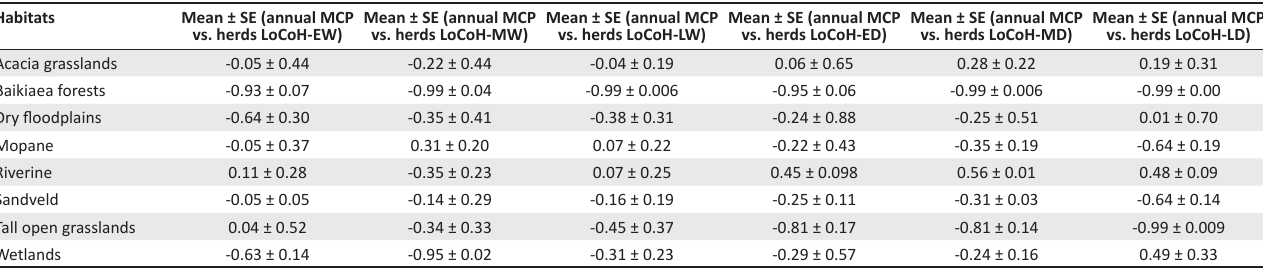
TABLE 3: Third-order habitat selection (annual minimum convex polygons vs. wet or dry season local convex hull) by three buffalo in the Savuti–Mababe–Linyanti ecosystem (northern Botswana).